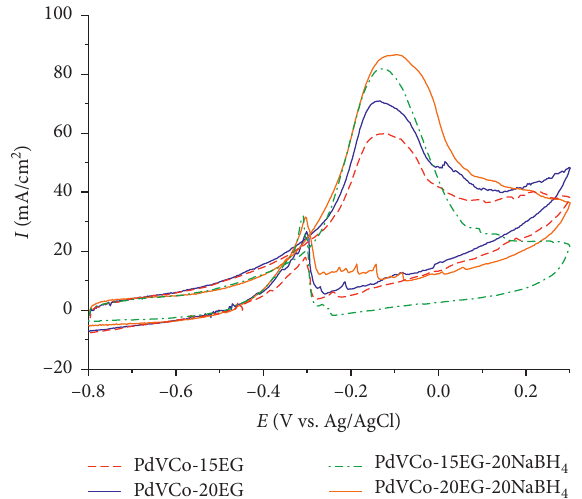
Figure 5: CVs of methanol electrooxidation on nanocatalysts PdVCo in a solution of 1 M KOH+1 M CH 3 OH.